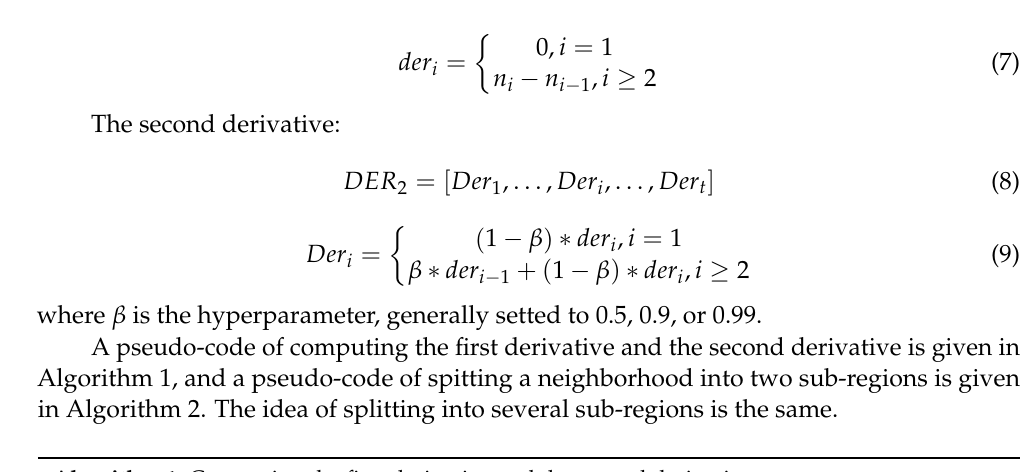
Algorithm 1: Computing the first derivative and the second